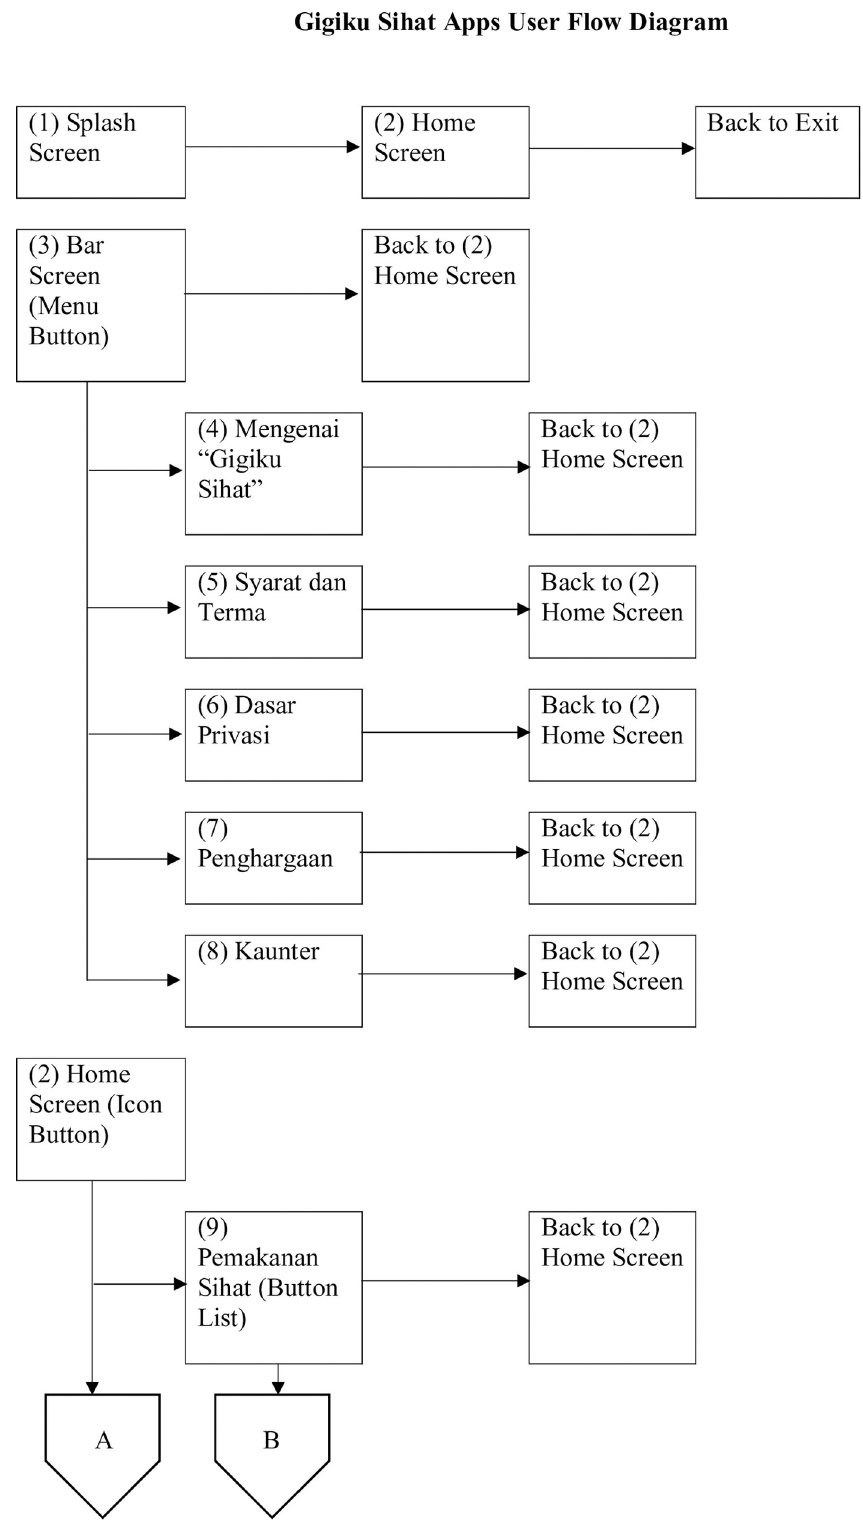
Fig 1. User flow diagram of Gigiku Sihat